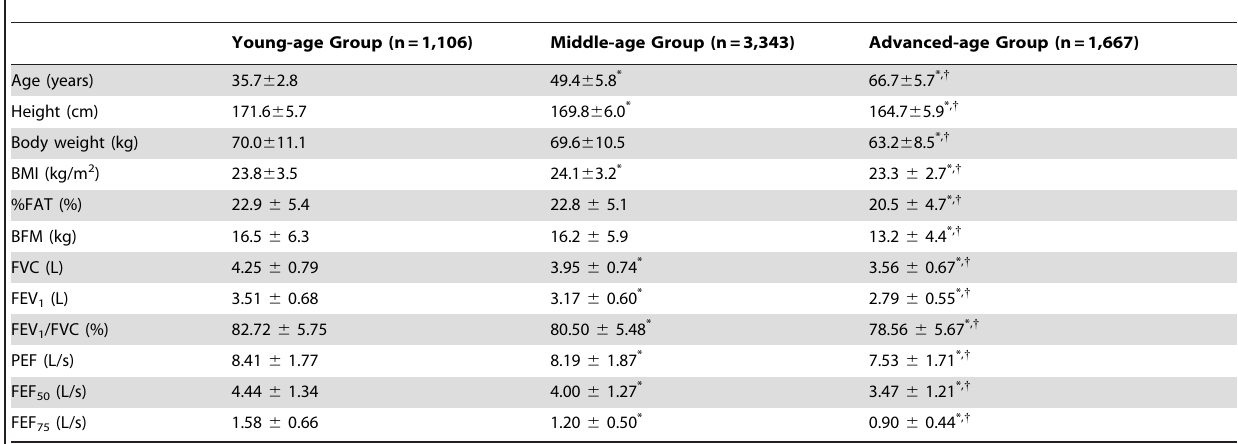
Table 1. Demographic, anthropometric, and spirometric characteristics of male participants.